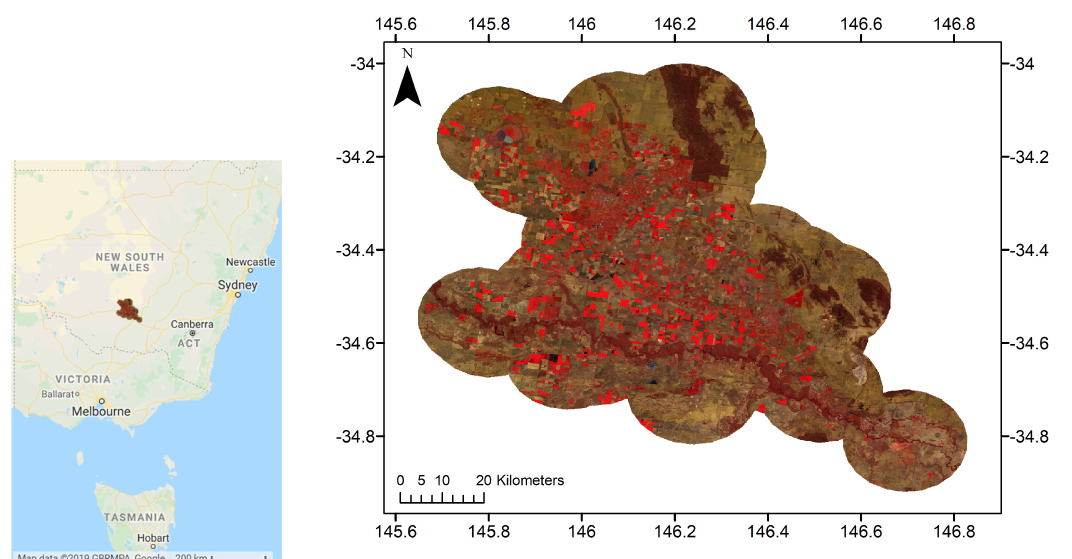
Figure 1. Map of the study area, showing a false color image ([R,G,B] = [NIR,R,G]) from a January 2019 Sentinel-2